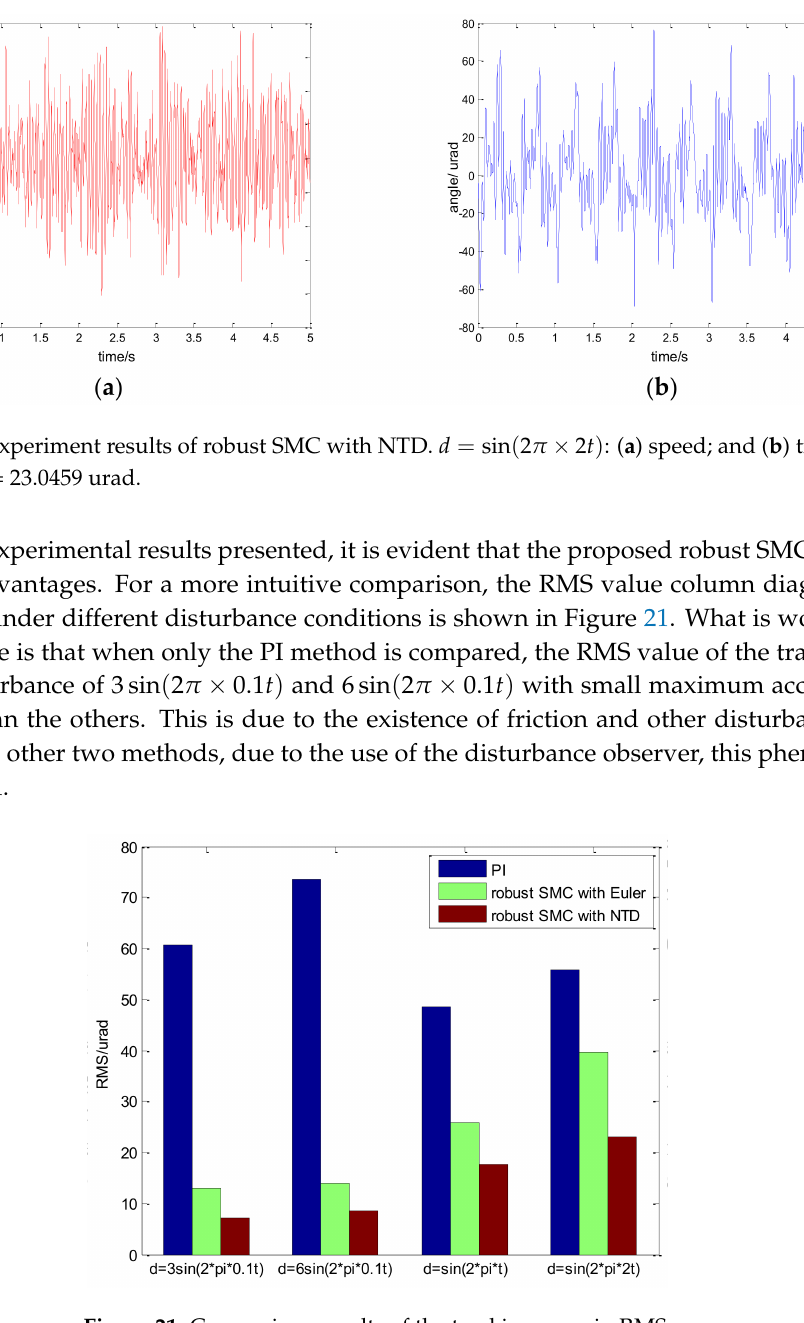
Figure 21. Comparison results of the tracking error in